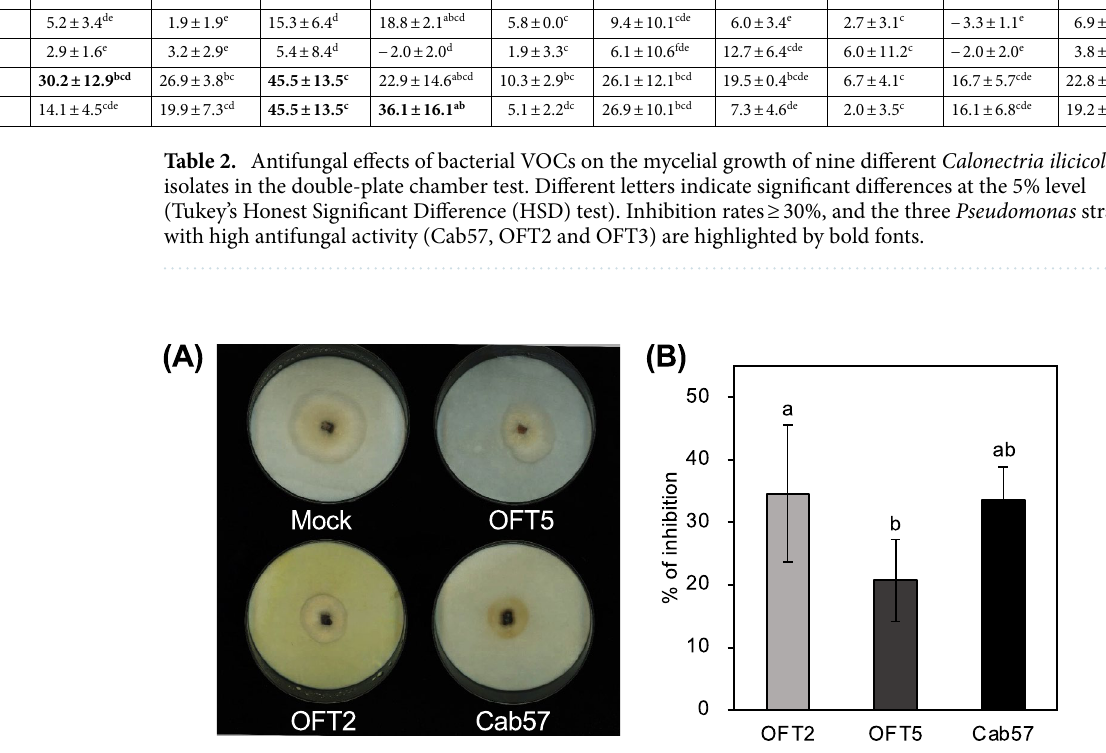
Figure 2. Suppressive effects of the culture supernatants of Pseudomonas strains (OFT2, OFT5, and Cab57) on C. ilicicola (UH2-1) mycelial growth. The supernatant prepared from the TSA medium without bacterial culture was used as the control (mock). ( A ) Plate images of C. ilicicola (UH2-1) growth in the presence of mock and bacterial culture supernatants, ( B ) mean (± standard deviation [SD]) growth inhibition rate (%) relative to the mock control (n = 9). Different letters next to error bars indicate that the means are significantly different from each other as per Tukey’s honest significant difference (HSD) test (p <